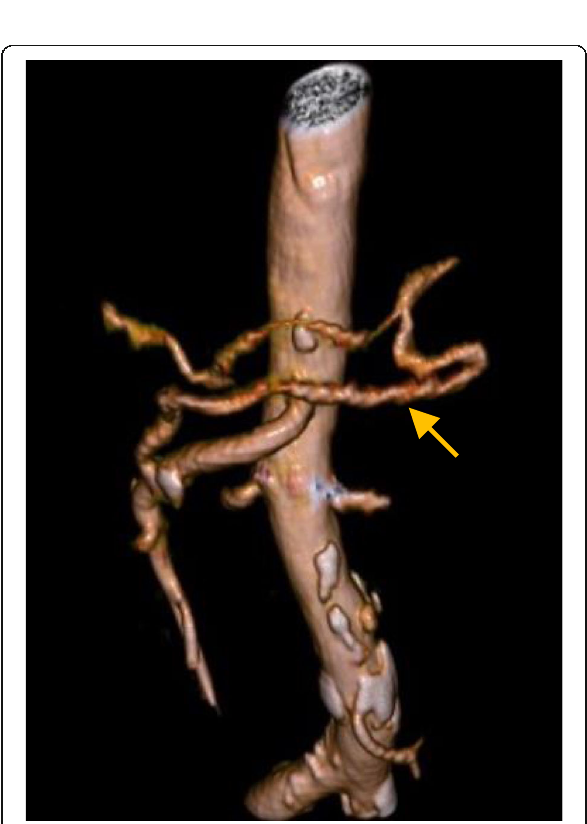
Fig. 7 Three-dimensional reconstruction of the peri-pancreatic arterial communication on the postoperative MDCT. The anastomosis between the SMA and SPA through the DPA was clearly detected (arrow). DPA, dorsal pancreatic artery; MDCT, multi- detector computed tomography; SMA, superior mesenteric artery; SPA, splenic